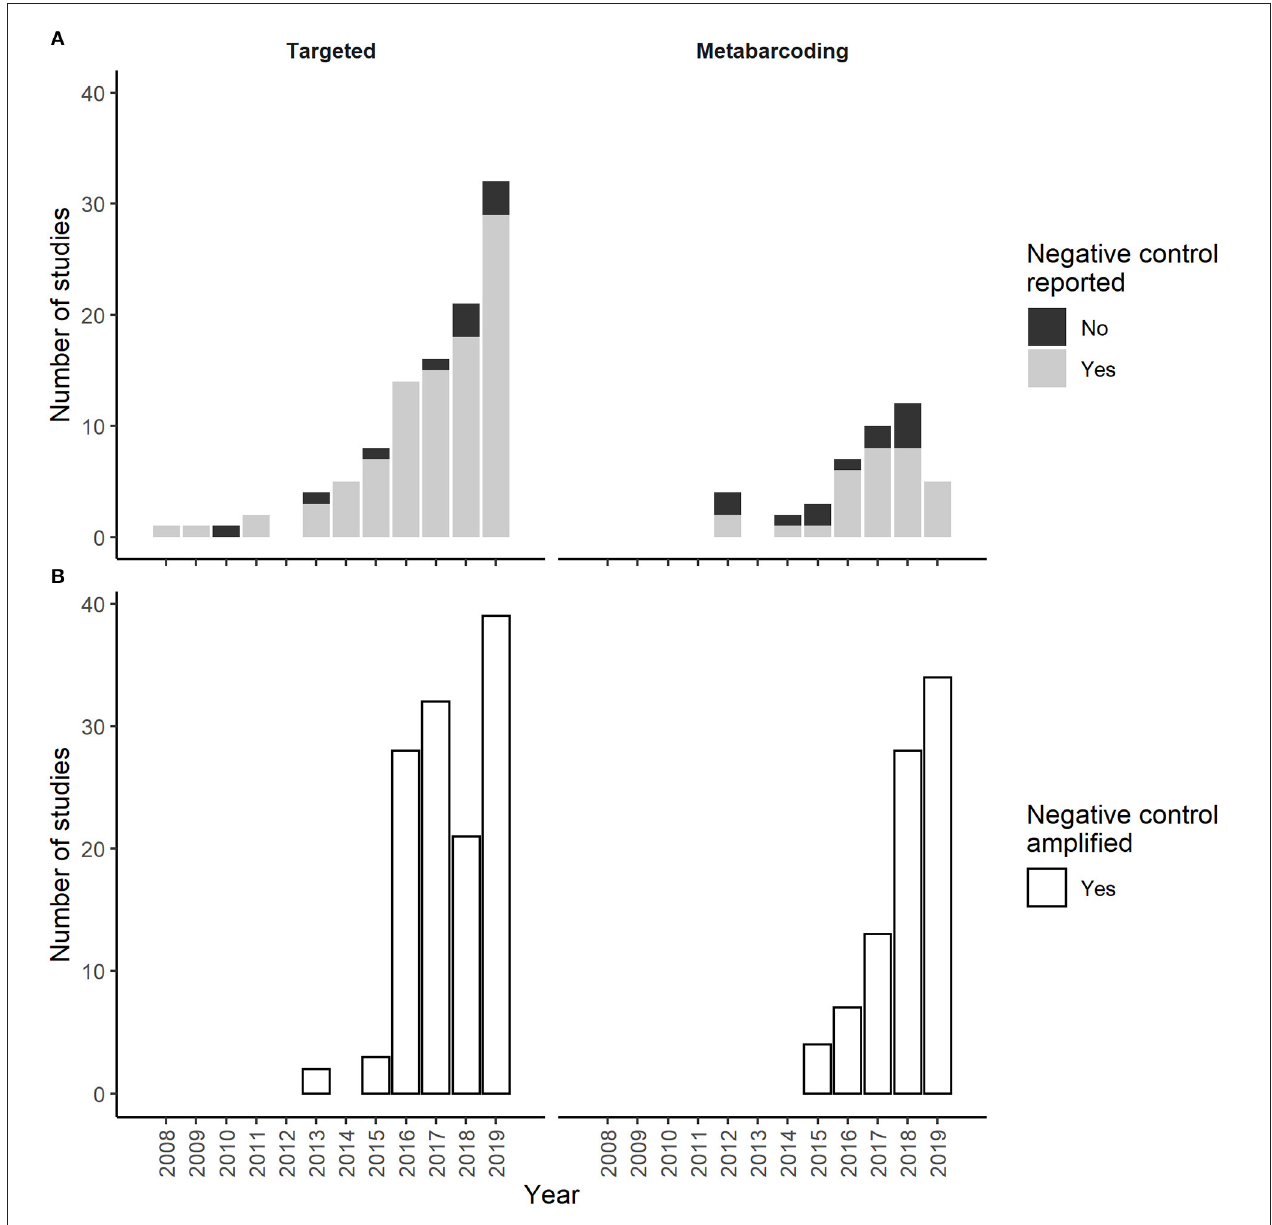
FIGURE 1 | The number of targeted and metabarcoding eDNA studies that (A) reported (Yes) or did not report (No) negative controls in the first literature review and that (B) reported (Yes) amplification of negative controls in the second literature review.